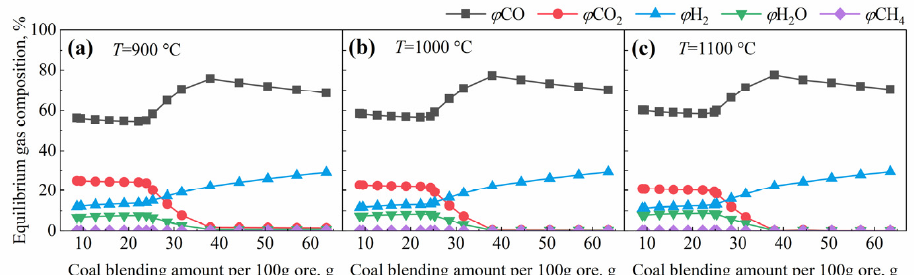
Figure 7. Composition and content of the equilibrium gas phase: ( a ) T = 900 °C; ( b ) T = 1000 °C; ( c ) T = 1100 °C.